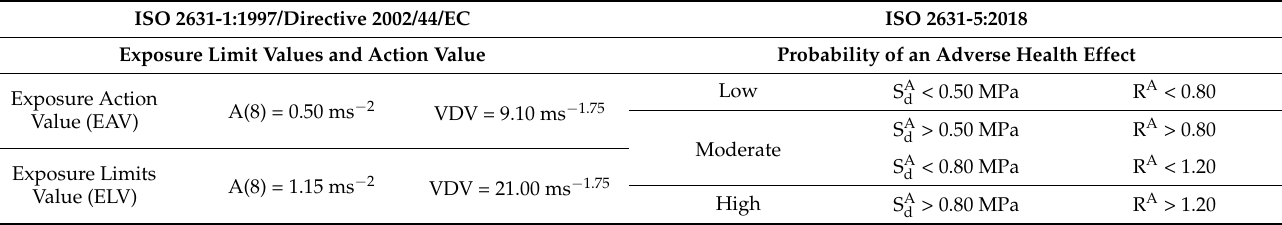
Table 3. Health guidance caution zone.